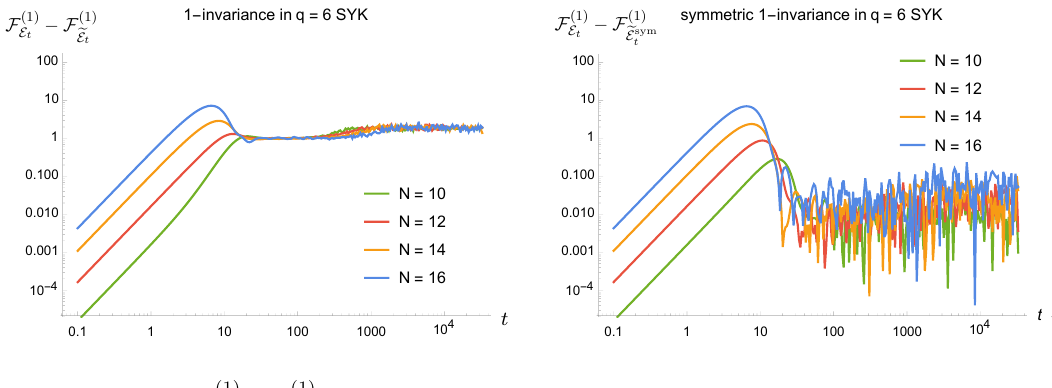
Figure 13 . Left: F (1) − F (1) , the difference between the frame potential for the q = 6 SYK model E t e E t and its unitary-invariant ensemble at different values of N . Right: the difference between frame potentials where e E sym is taken to be the invariant ensemble with respect to appropriate symmetry t classes for the given N and q